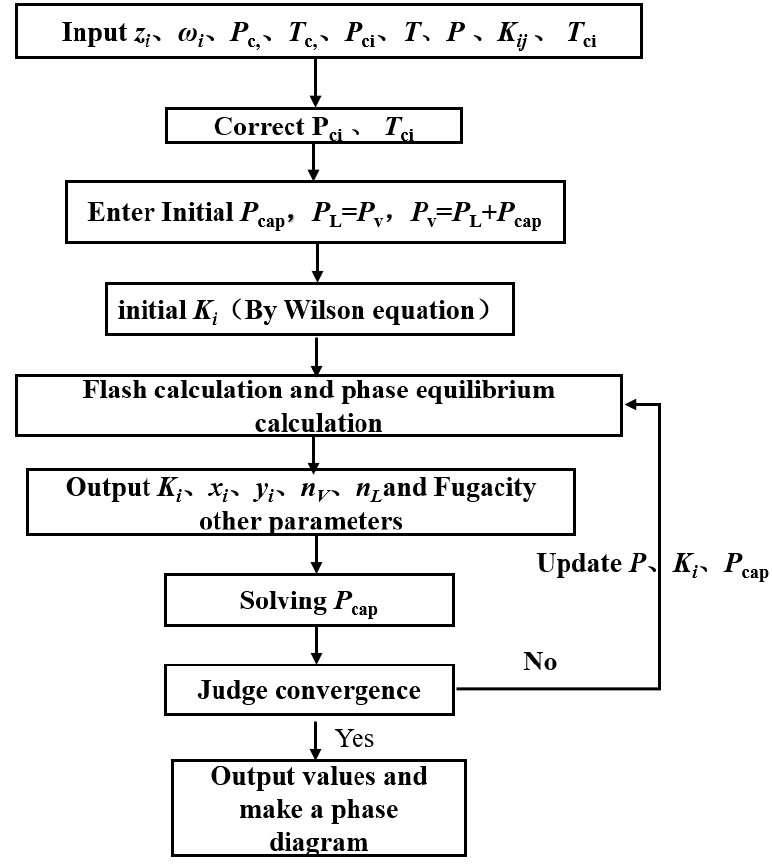
Figure 7. Flow chart of phase equilibrium calculation (modified from [83]). Through the above calculation process, the phase state diagram can be drawn for different pore diameters, and the phase state diagram considering the pore confinement effect is roughly shown in Figure 8 [84].